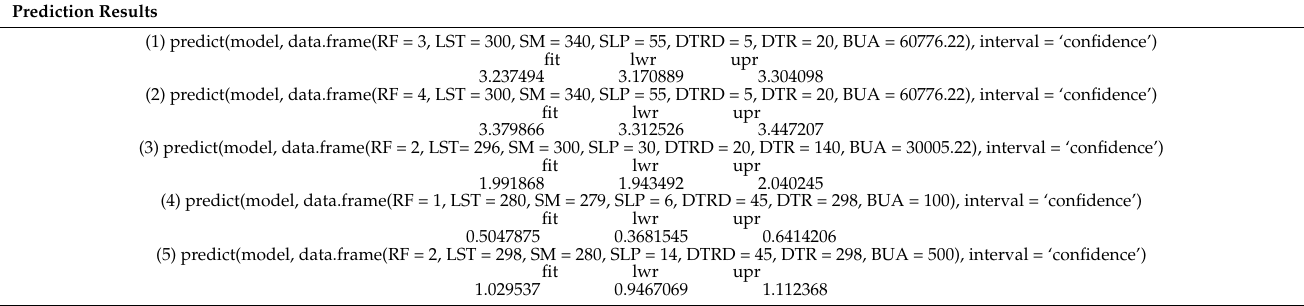
Table 8. The modelled landslide chances as the upper limit, lower limit, and